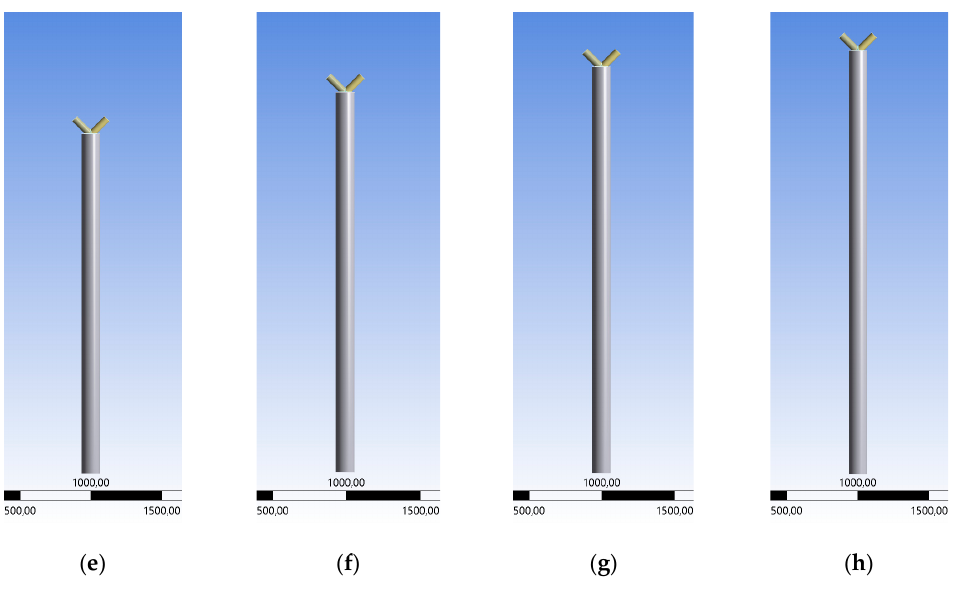
Figure 7. Variable Chord lengths, 1.5–3.0 m.